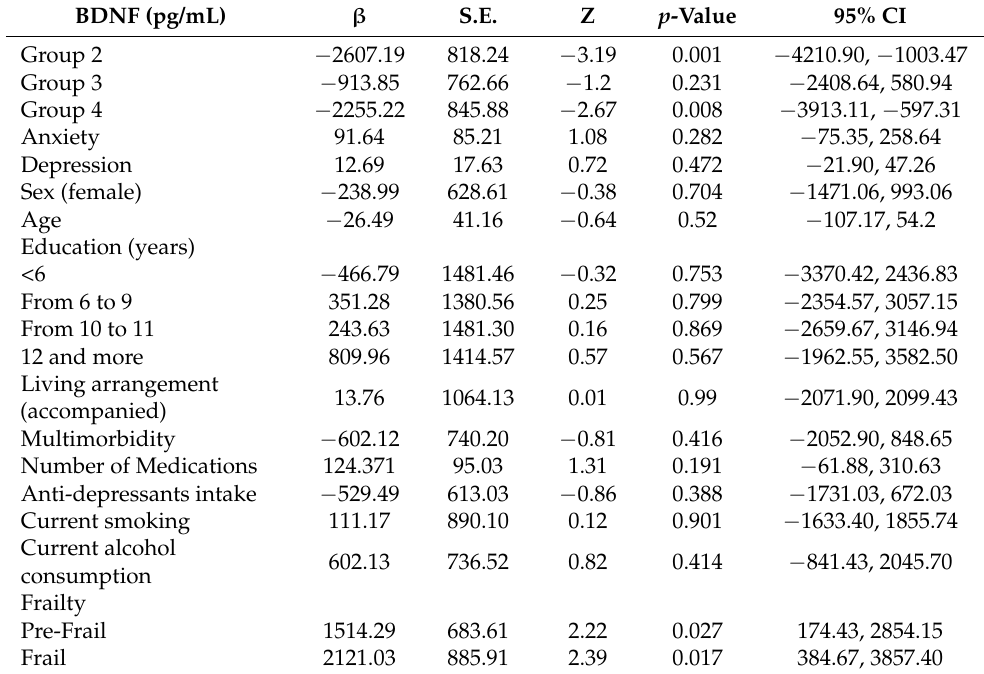
Table 4. Adjusted linear regression model for the association between considered groups including insomnia and cognitive decline on BDNF concentration in